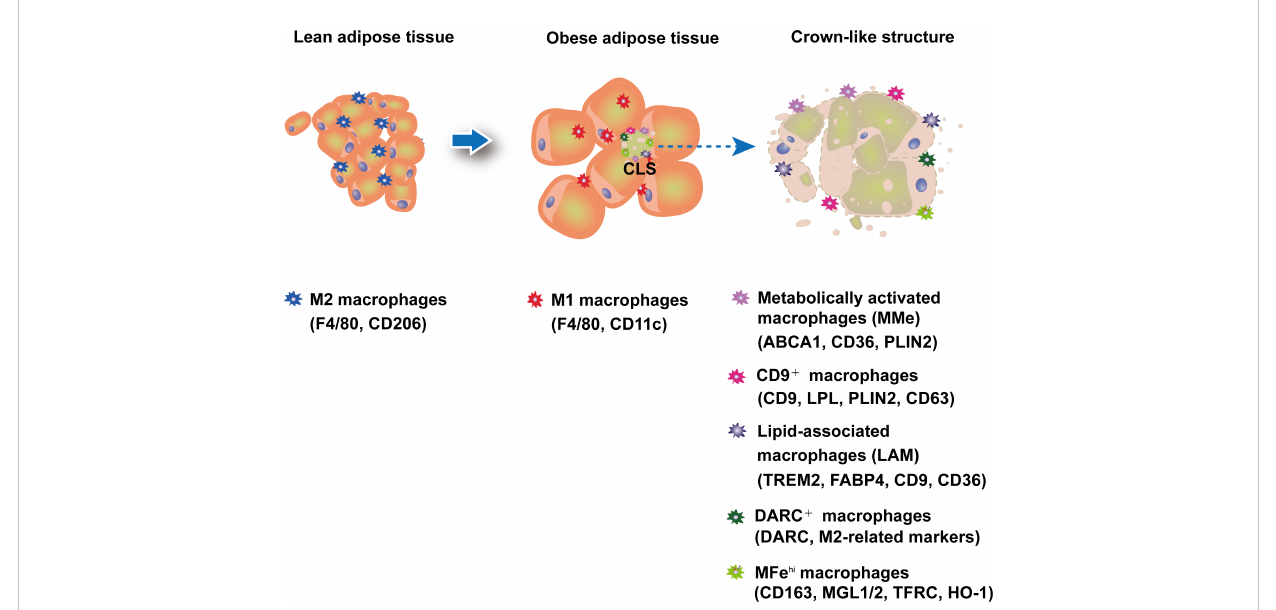
FIGURE 1 ATMs plasticity in adipose tissue. In lean adipose tissue, anti-in fl ammatory M2-like macrophages are predominant and maintain homeostasis. In obese adipose tissue, an increase in pro-in fl ammatory M1 ATMs forms a crown-like structure (CLS) surrounding dead adipocytes. Recent research has uncovered new macrophage subtypes, particularly in